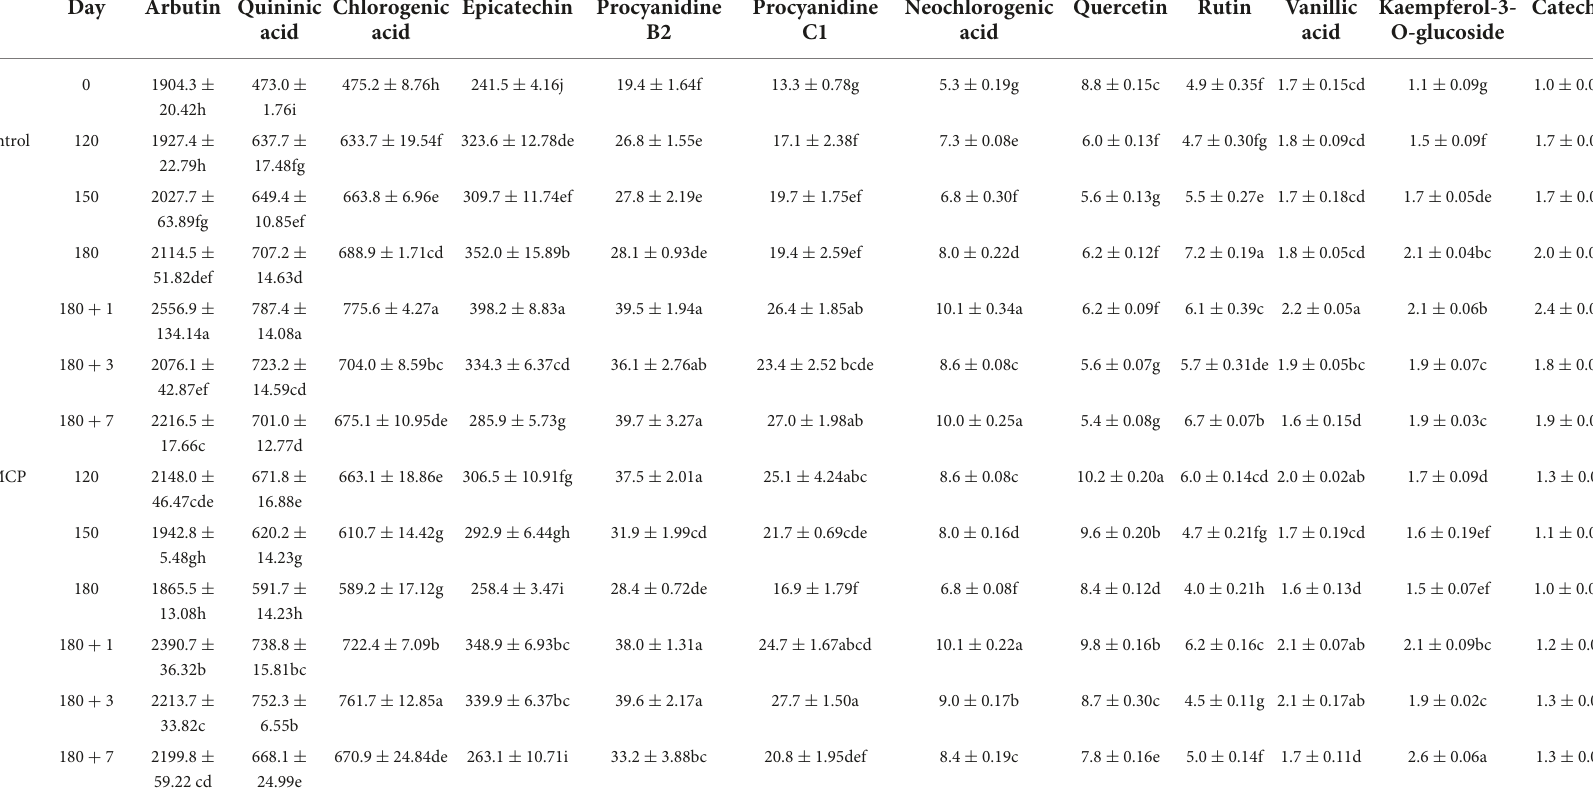
TABLE 1 Effect of 1-MCP on contents of phenolic acids and flavonoids of the peels in “Yali” pear (mg kg − 1